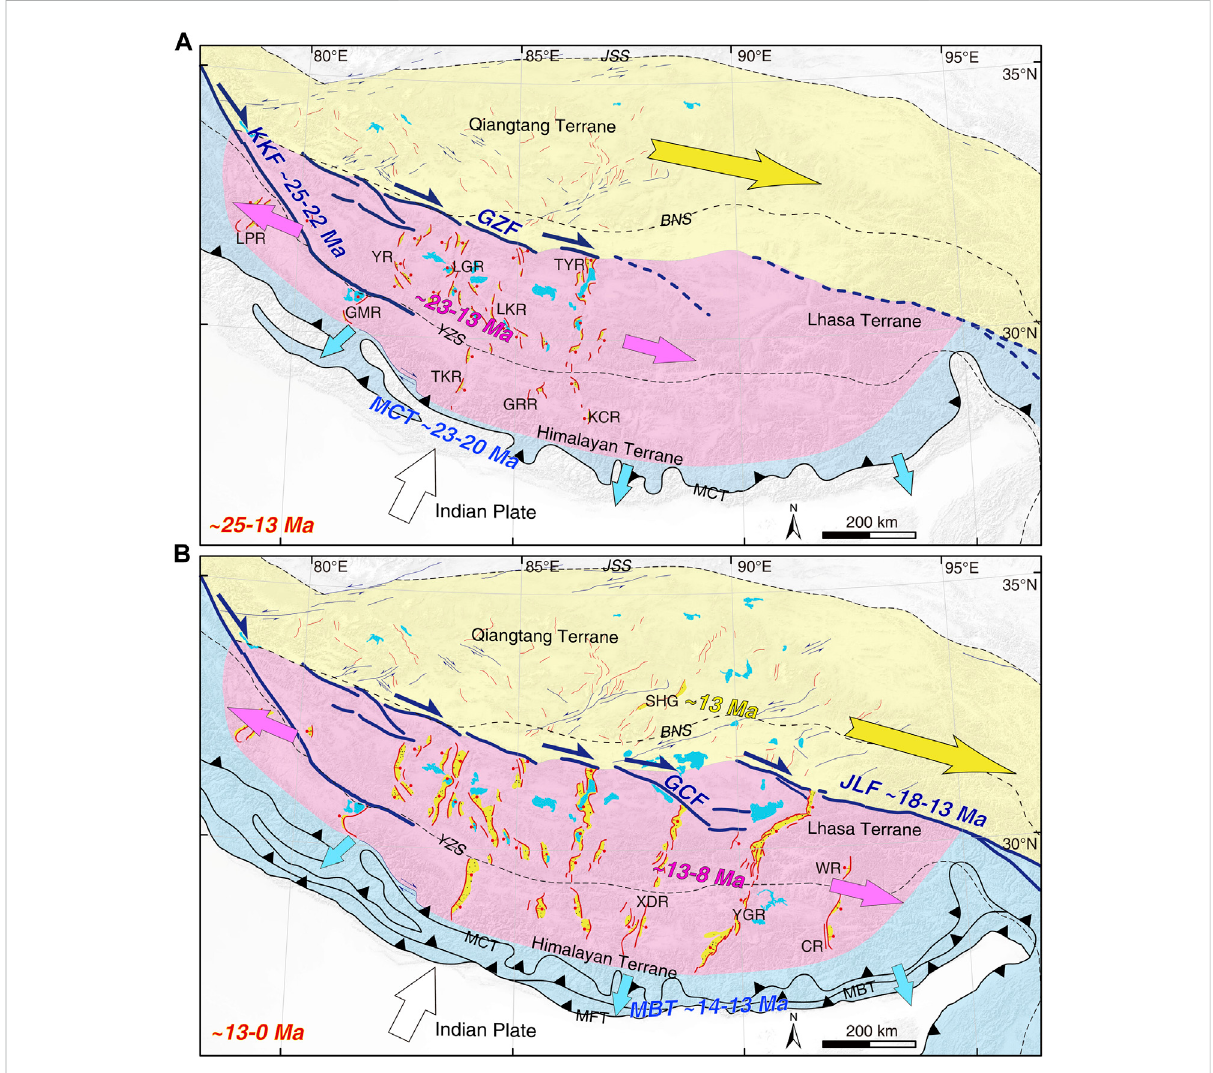
FIGURE 8 E-W extension kinematic model of southern Tibet. (A) Formation of rifts in the western half of southern Tibet are controlled by the Karakorum- Gaize fault (~25 – 22 Ma) and Main Central Tibet (~23 – 20 Ma). (B) Rifts in the eastern half of southern Tibet formed by eastward propagation of GyaringCo-Jiali fault(~18 – 13 Ma)andMainBoundaryfault(~14 – 13 Ma)alongthecurvedHimalayanarc.AgereferencesarelistedinSupplementary Tables S1, S4. Yellow area and arrow represent the eastward extrusion of Qiangtang terrane. Pink area and arrows represent the E-W extension of arcuate southern Tibet. Blue area and arrows represent the divergent orthogonal thrusting along the curved Himalayan arc. Main rifts and sutures are: CR, Cona rift; GMR, Gurla Mandhata rift; GRR, Gyirong rift; KCR, Kung Co rift; LGR, Lunggar rift; LPR, Leo Pargilrift; SHG, Shuanghu graben; TKR, Thakkholarift;TYR,TangraYumcorift;WR,Wokarift;XDR,Xainza-Dinggyerift;YGR,Yadong-Gulurift;YR,Yaririft;GCF,GyaringCofault;GZF,Gaize